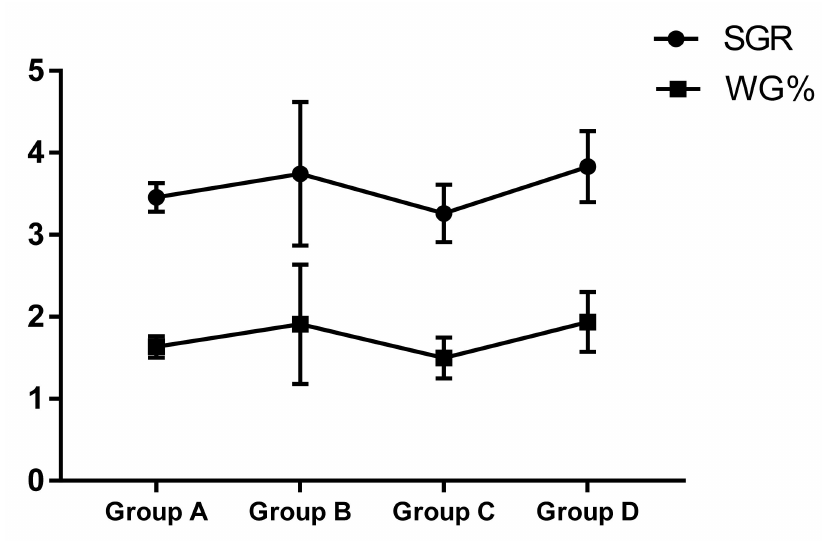
Figure 1. SGR and WG% of largemouth bass among each group after the trial.